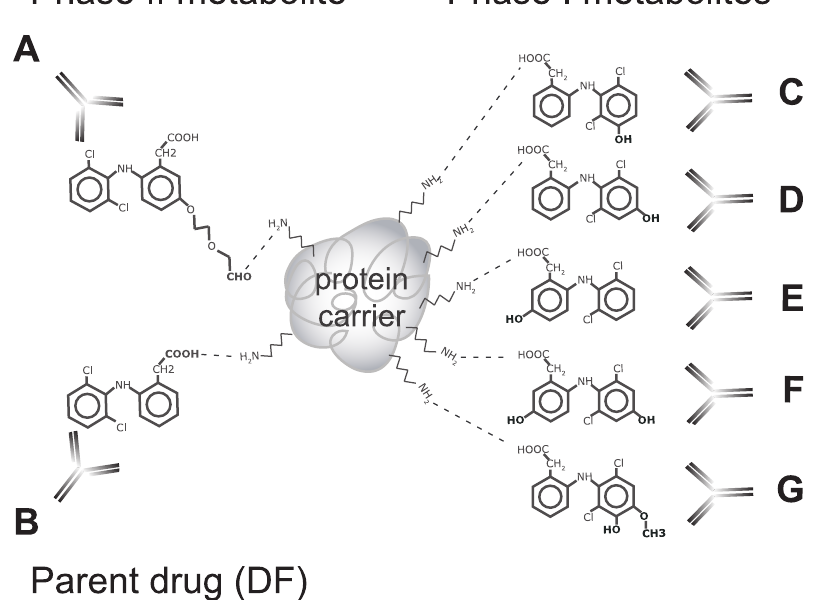
Figure 1. Coupling strategy. Bioactivation resulting in haptenation was mimicked by linkage of native DF (A) via position 5 or (B) via position 1 and linkage of five Phase I DF-metabolites (C) 3 9 OH-DF, (D) 4 9 OH-DF, (E) 5OH-DF, (F) 4 9 5diOH-DF, (G) 3 9 OH4 9 metO-DF via position 1 to HSA as protein carrier.